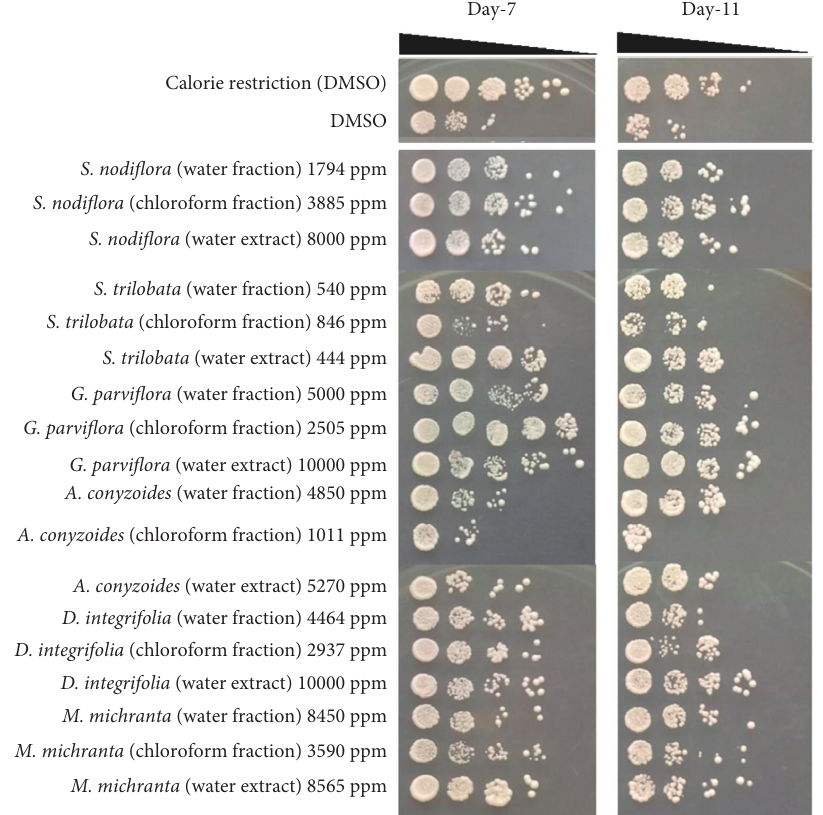
Figure 2: Effect of plant extract and fractions on yeast cells viability during stationary phase (chronological aging). Yeast cells were grown in a YES medium containing an optimum concentration of plant extract/fractions as observed previously. Yeast cells grown in EMM medium supplemented with DMSO were designated as calorie restriction for control positive treatment, while yeast cells grown in YES medium supplemented with DMSO only without any extract/fractions addition were used as control. Each culture treatment was then incubated for 7 and 11 days and subjected for spot assay on YES agar. Plates were incubated for three days at 30 °